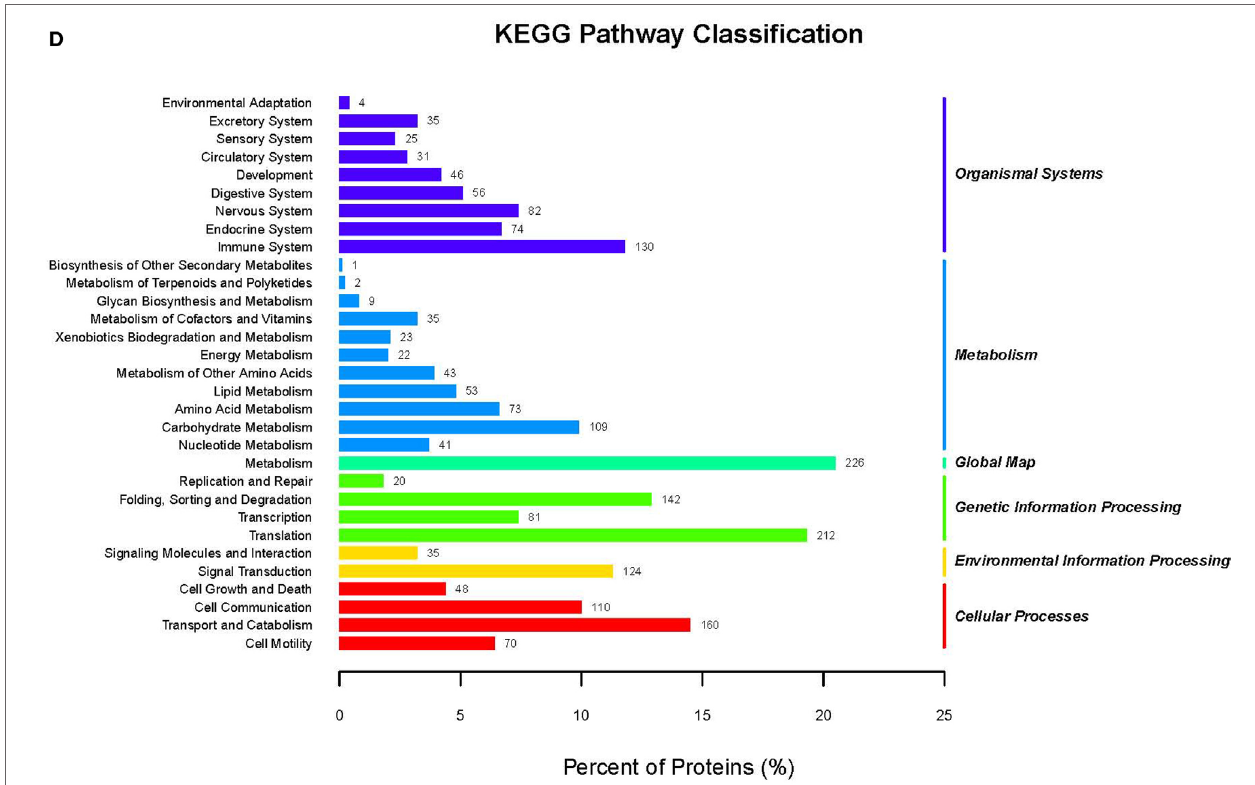
FigUre 2 | gene ontology analysis of proteins in hemocytes of healthy crabs based on cellular component (a), biological process (B), molecular function (c), and Kyoto encyclopedia of genes and genomes (Kegg) pathway classification (D) of proteins in the hemocytes of healthy